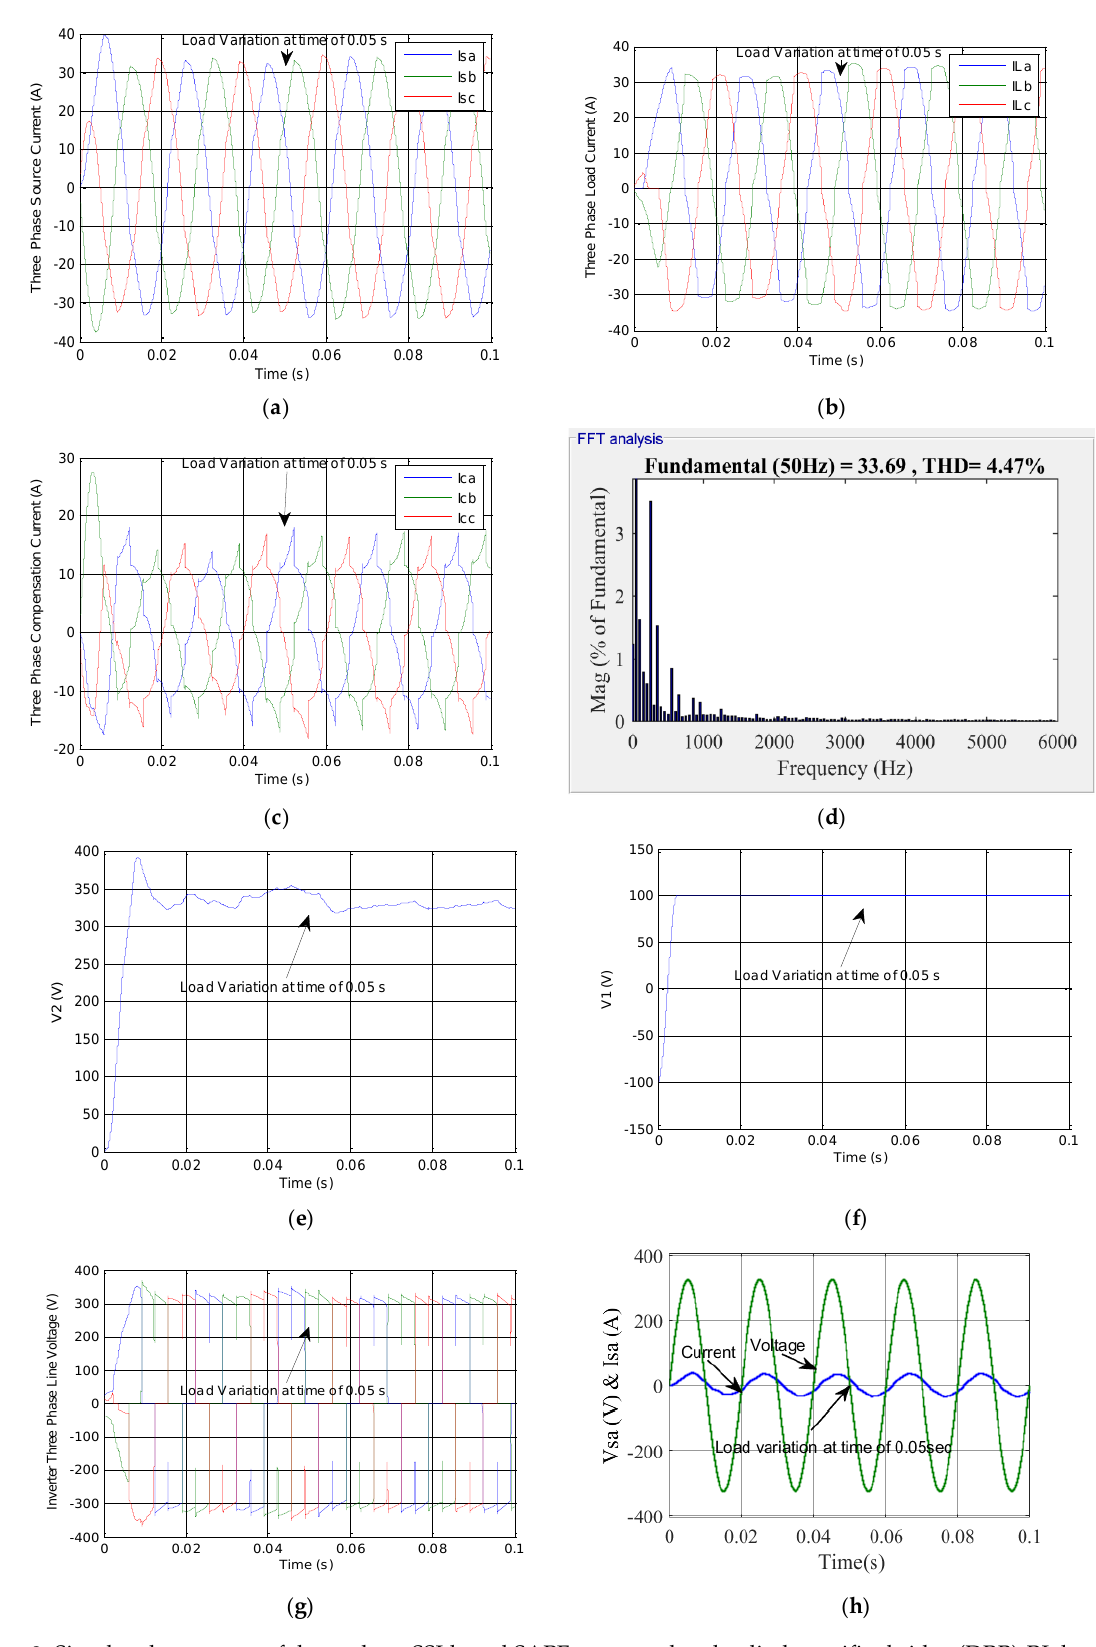
Figure 8. Simulated responses of three-phase SSI-based SAPF connected at the diode rectifier bridge (DRB)-RL load HCC and PI controller, ( a ) supply current, ( b ) load current, ( c ) compensation current, ( d ) THD, ( e ) V 2 DC link voltage, ( f ) V 1 DC link voltage, ( g ) SSI output voltage and ( h ) source voltage (V sa ) and source current (I sa ) of phase A.